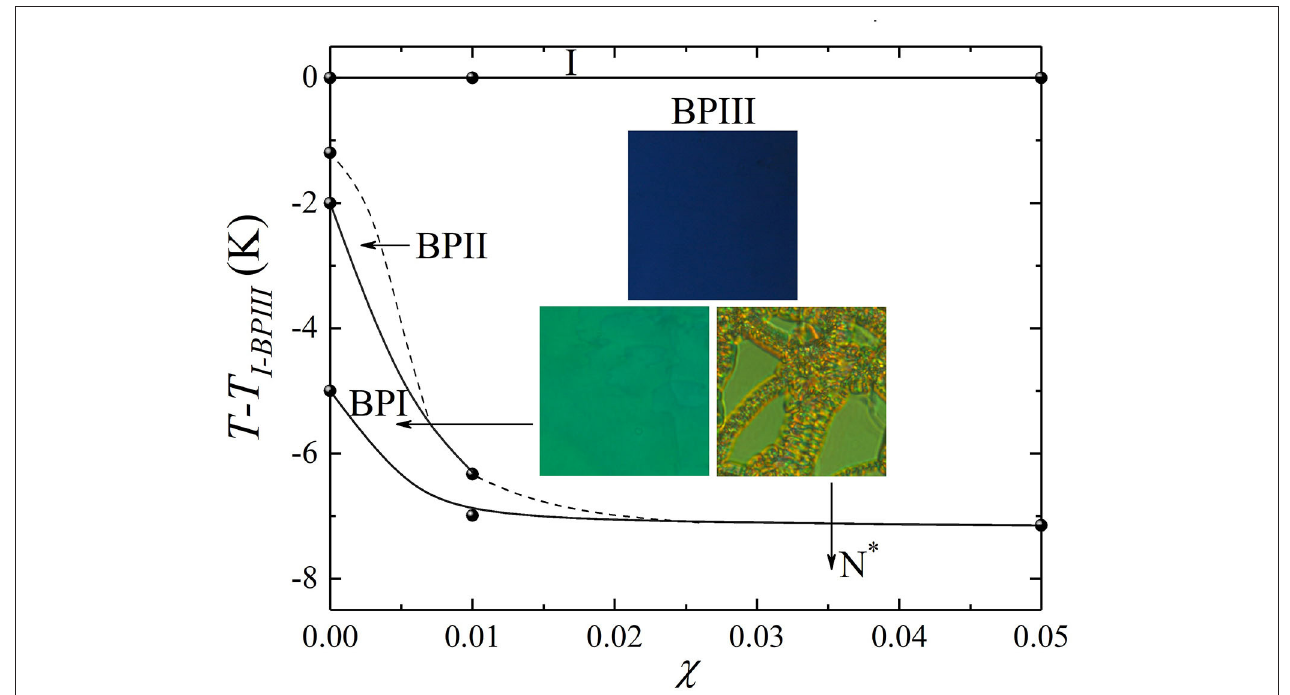
FIGURE 3 | Temperature vs. concentration ( T- χ ) phase diagram obtained for CE8 and CdSSe nanocomposites, upon cooling, by ac calorimetry and polarizing optical microscopy. The I-BPIII transition temperature ( T I − BPIII ) has been subtracted from absolute values in all cases. The solid circles represent the phase transition temperatures obtained by ac calorimetry, and the solid lines that connect them serve as guides to the eye. The dotted lines indicate the termination of the BPIII-BPII and the BPIII-BPI phase transition lines. The images (insets) show the foggy blue BPIII texture, the turquoise-green BPI platelets and the N* oily streaks for the χ = 0.01